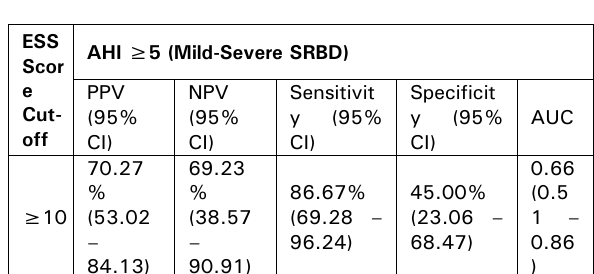
Table 3. Utility of Epworth Sleepiness Scale score in screening for sleep related breathing disorders (SRBD) in patients with respiratory symptom complex attending